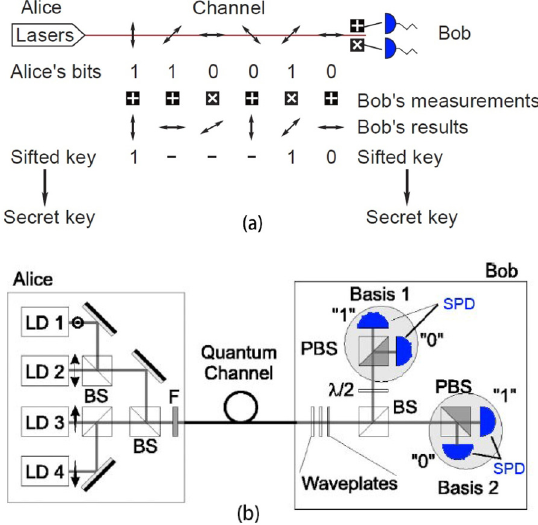
Figure 1: (a) Schematic of the BB84 protocol. Two or four SPDs are required in the system with/without a polarization